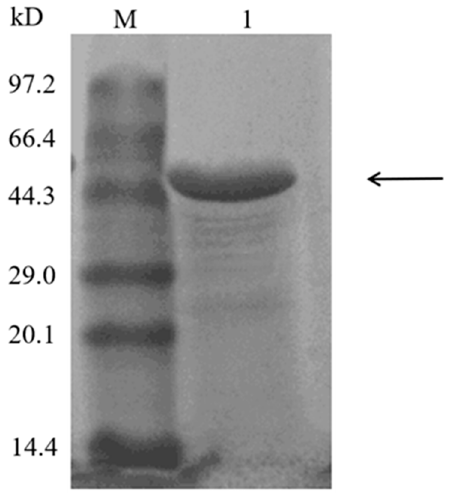
Figure 1. Expression and analysis of the molecular weight of Melac13220 via SDS-PAGE using SP cationic exchange column. Lane M: molecular weight marker; Lane 1: purified Melac13220. The band of Melac13220 is marked with black arrow.